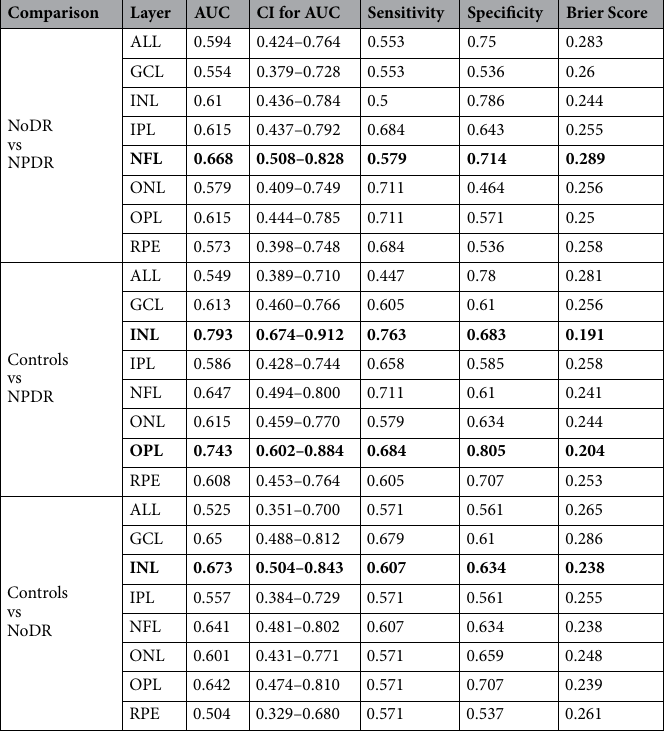
Table 3. Results of the predictive performance using summary statistics (five-number summary) as predictors for pairwise comparisons among controls, NoDR and NPDR based on seven retinal layers and overall retinal thickness. ALL stands for the overall thickness. The layers which are statistically significant in demonstrating discriminatory power for each pairwise comparison (lower bound for CI > 0.5) are shown in bold font.